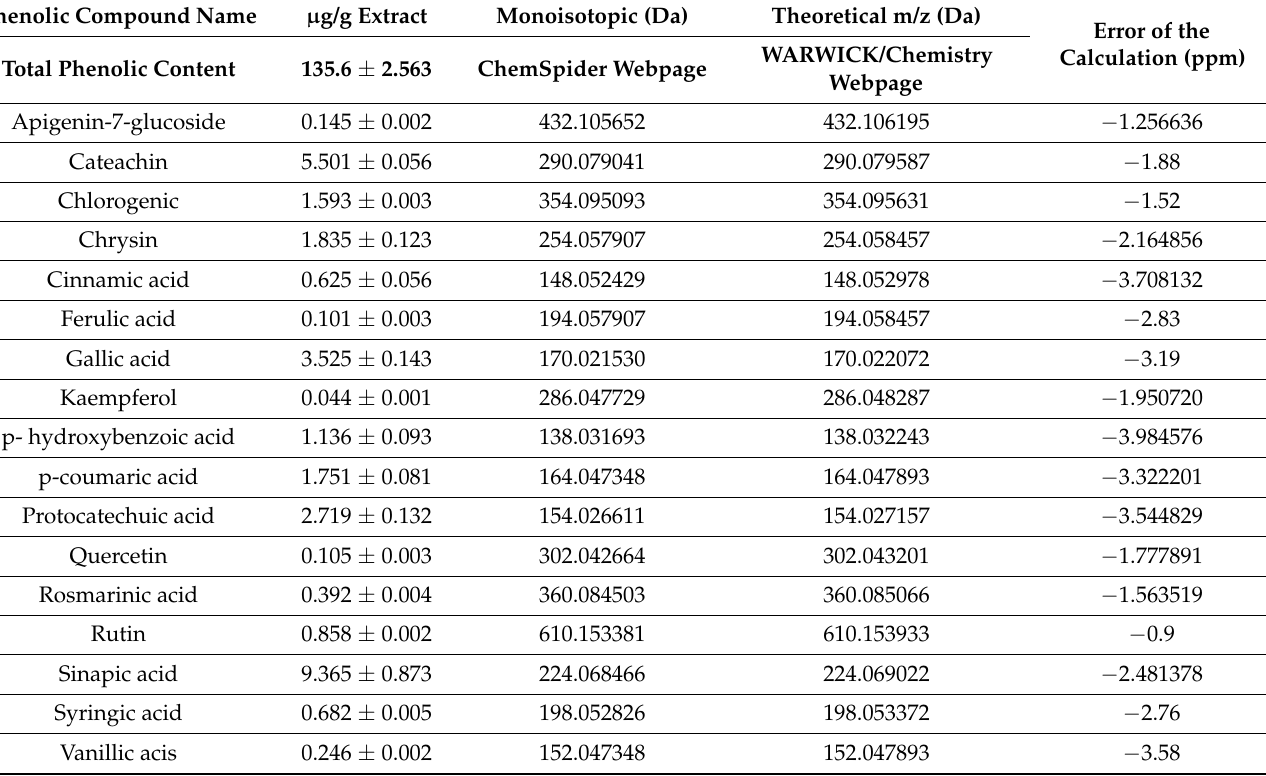
Table 1. Total phenolic content and different phenolic compounds of Calluna